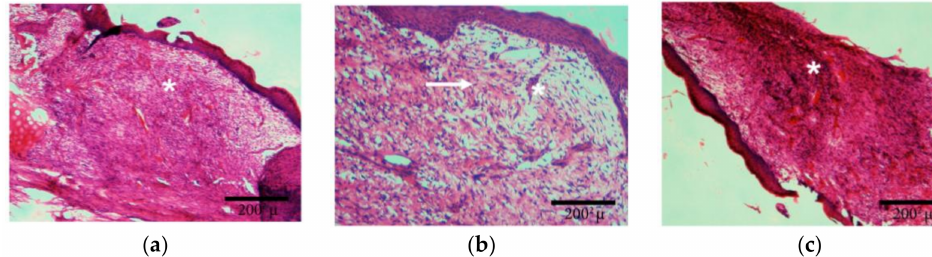
Figure 4. Histology of skin wounds in rabbits after 15 days of treatment. ( a ) Control: star—vascular granular tissue; ( b ) Ch/HA membrane: arrow—likely site of activated fibroblasts with formation of collagen fibres (it is acknowledged that a Masson trichrome or immunostaining is required to accurately identify these entities), star—newly-formed veins; ( c ) Ch/HA/MitoQ membrane: star—nonspecific granular tissue in the initial stage with enhanced